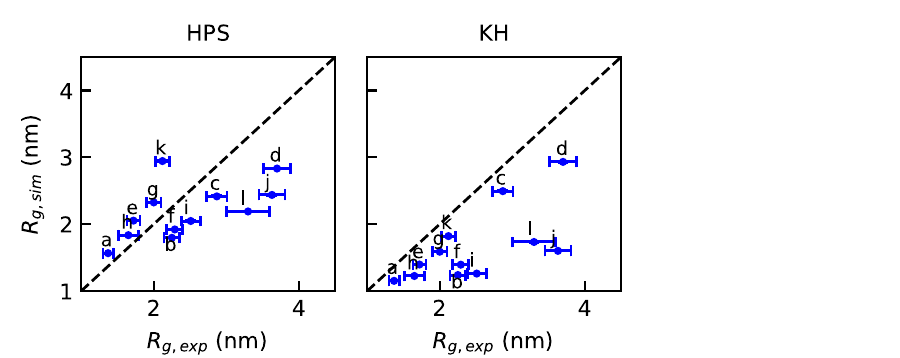
Fig 2. Parameterization of coarse-grained models: Comparison between radius of gyration of various intrinsically disordered proteins from experiment, and from simulation with the optimal parameters.